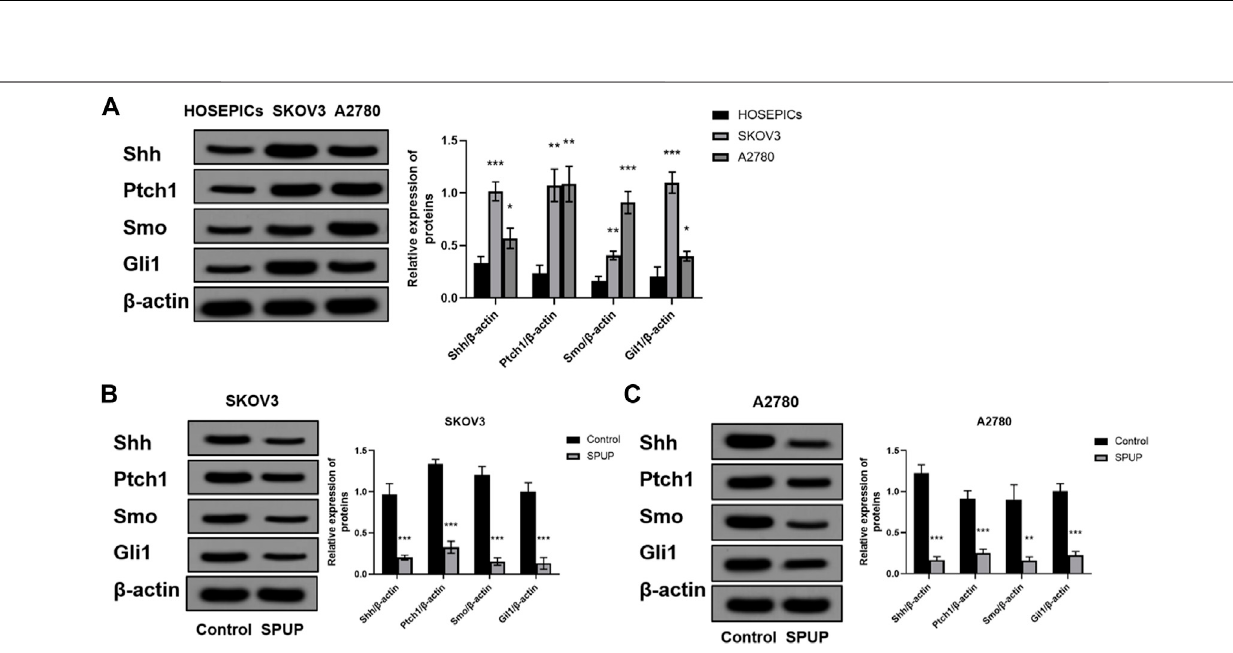
FIGURE 6 | Effect of SPUP on Hh signal pathway activity of OC cells; (A) protein expression of OC cells and HOSEPICs cells; (B,C) protein expression of SKOV3 and A2780 cells. * p < 0.05, ** p < 0.01, *** p < 0.001 compared with HOSEPICs or control group. SPUP could inhibit the proliferation, invasion, and migration and promoted apoptosis by regulating the activation of the Hh signaling